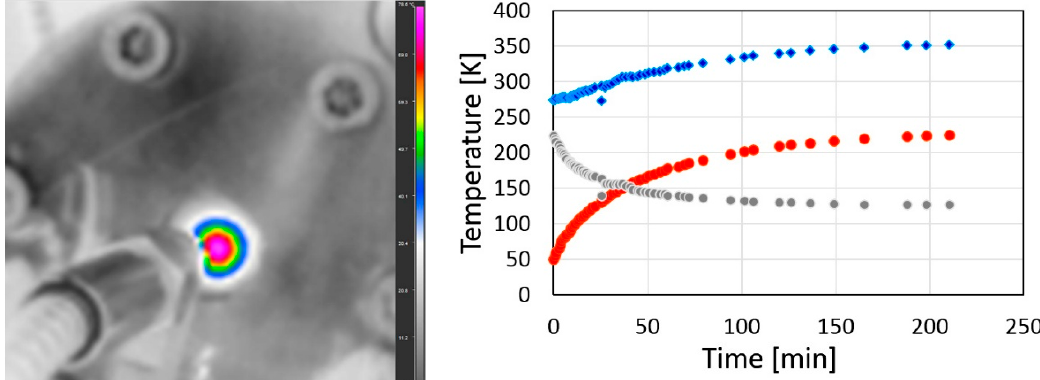
Figure 18. Left : Heating spot in the Highly Oriented Pyrolytic Graphite (HOPG) graphite induced by infrared light. Right : Temperature values as a function of time measured in the center of the graphite (blue diamonds) and on the cold finger (red circles), when an optical power of about 21 W was applied to the graphite being cooled by the cryo-refrigerator. The difference between the two temperatures is also reported (gray circles).